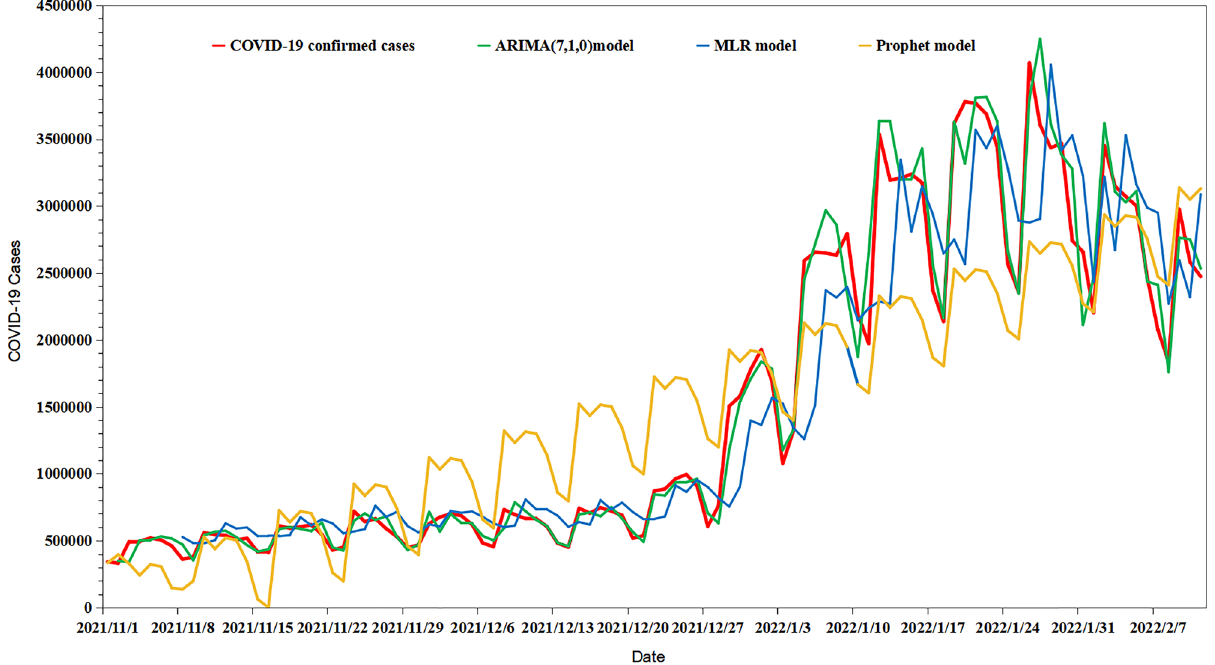
Figure.9. Comparison of prediction performance by ARIMA, MLR, and Prophet models.